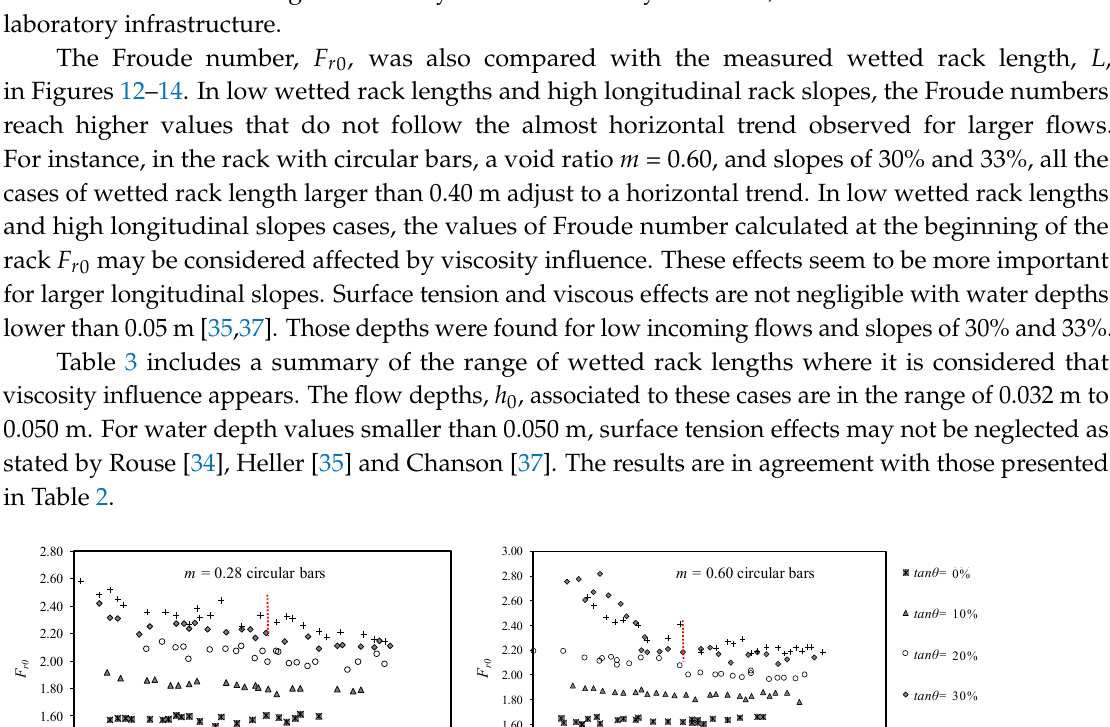
Figure 13. Froude number at the beginning of the rack F r0 as a function of the wetted rack length for T-shaped flat bars with void ratios m = 0.16 and 0.22. Figure 14. Froude number at the beginning of the rack F r0 as a function of the wetted rack length L , for T-shaped flat bars with void ratio m = 0.28. Table 3 includes a summary of the range of wetted rack lengths where it is considered that viscosity influence appears. The flow depths, h 0 , associated to these cases are in the range of 0.032m to 0.050 m. For water depth values smaller than 0.050 m, surface tension effects may not be neglected